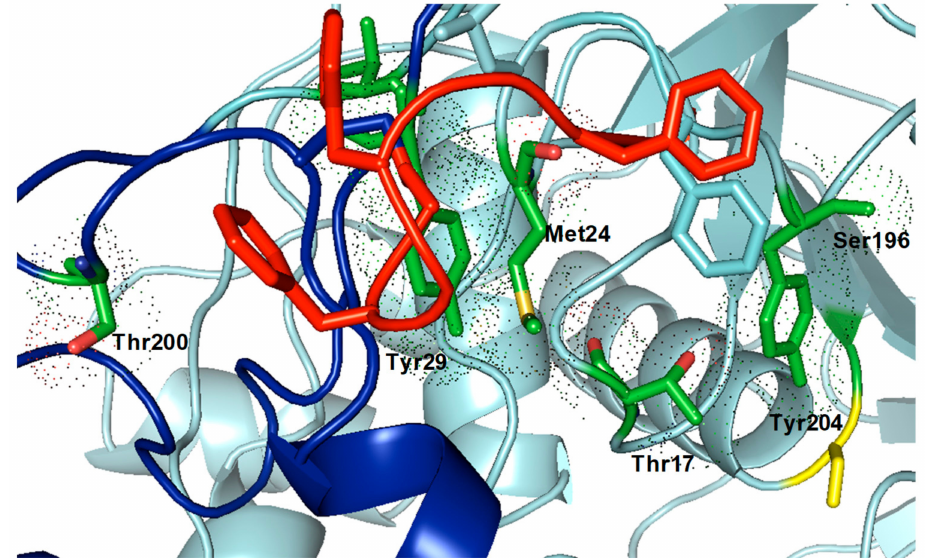
Figure 5. Crystal structure of the active form of the artificial enzyme GTL σ -A193Cp. Cartoon of the peptide sequence and the selected alcoholic protein residues. A193C-catalytic Ser114 is marked in yellow, lid in blue, peptide in red and the different Ser, Thr, Tyr or Met residues in green. All pictures were created by using